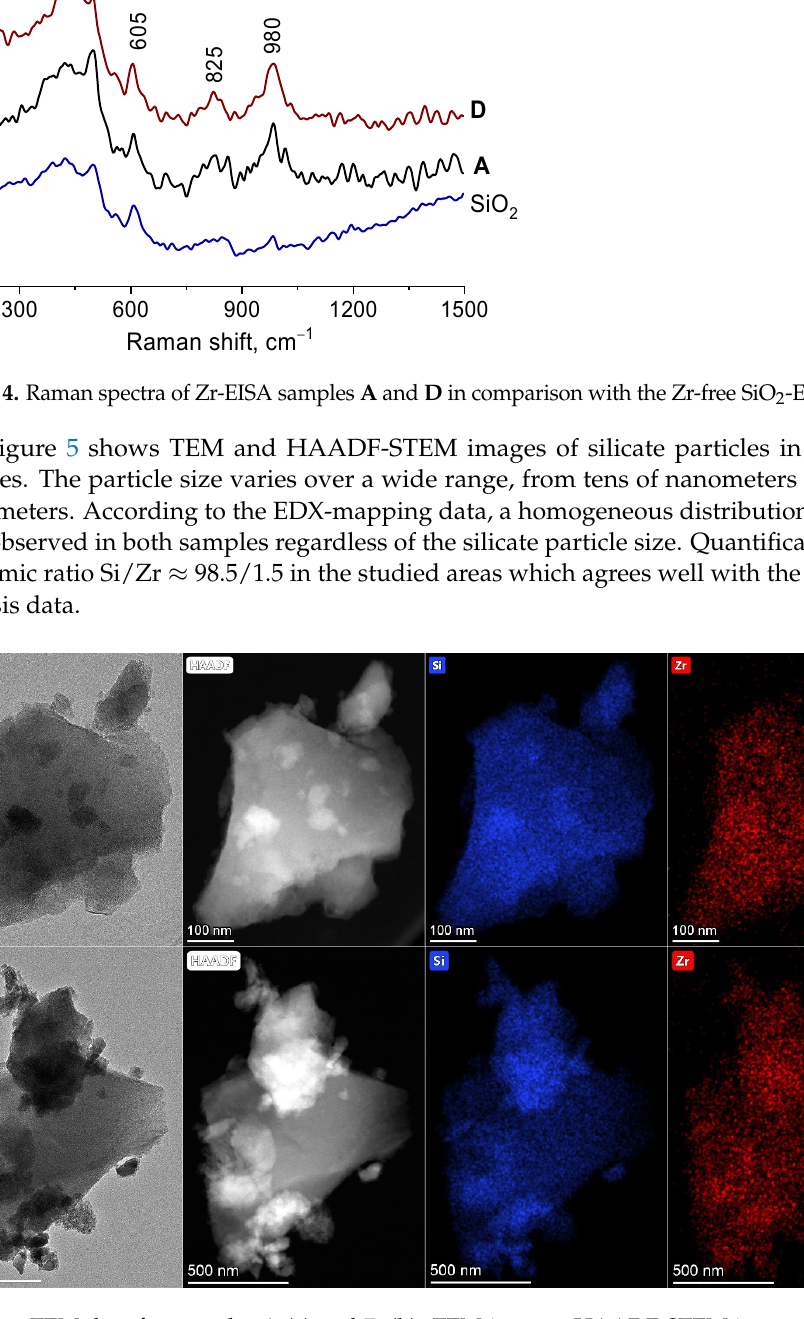
Figure 5. TEM data for samples A ( a ) and D ( b ): TEM-images, HAADF-STEM images and corre- sponding EDX-mapping patterns showing distribution of Si (blue) and Zr (red) in selected regions.